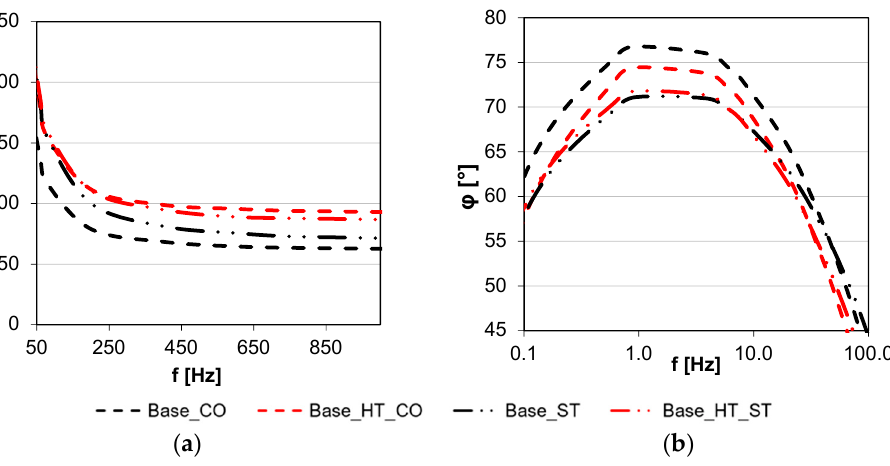
Figure 3. Bode representation of the impedance spectrum for materials welded with cobalt and stainless steel filler materials: ( a ) modulus vs. frequency, ( b ) phase angle vs. frequency.